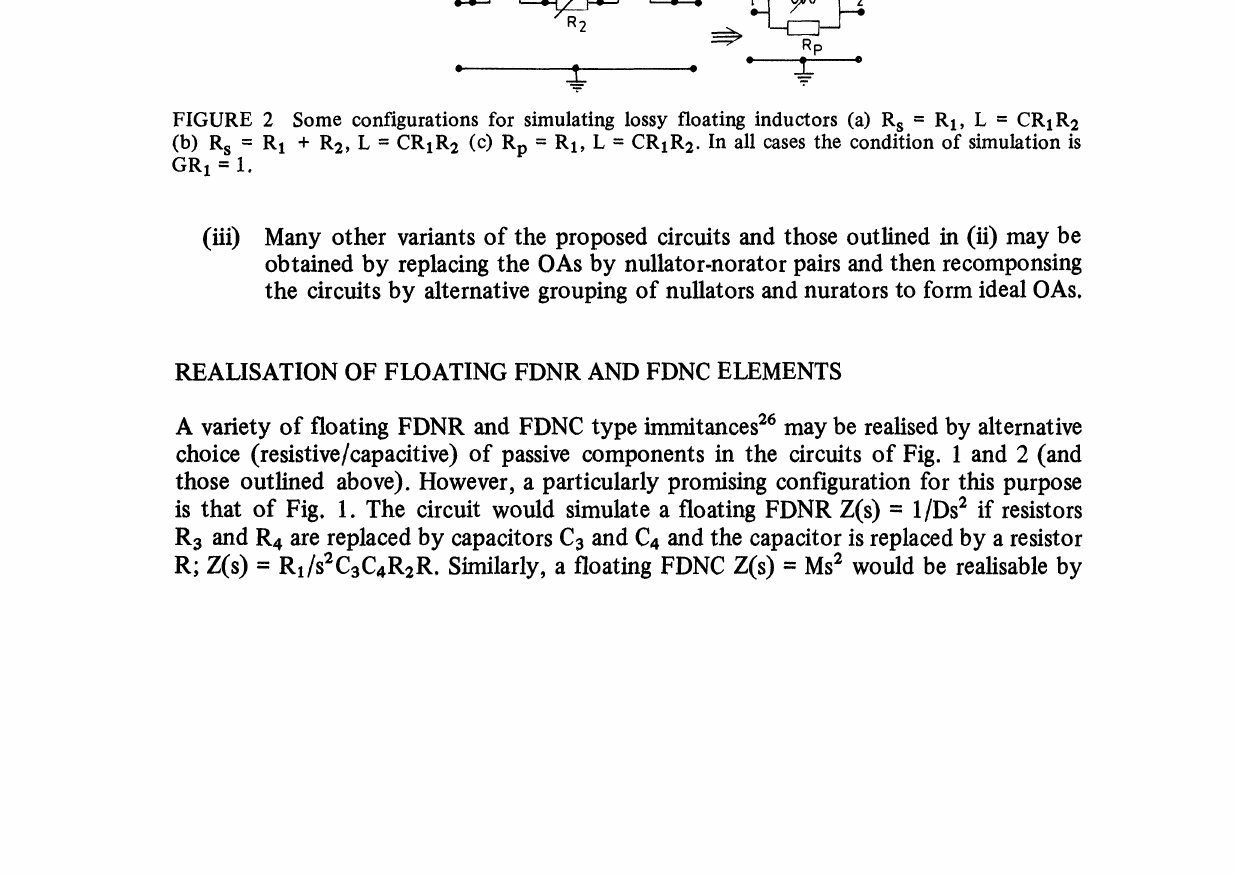
FIGURE 2 Some configurations for simulating lossy floating inductors (a) R GR1